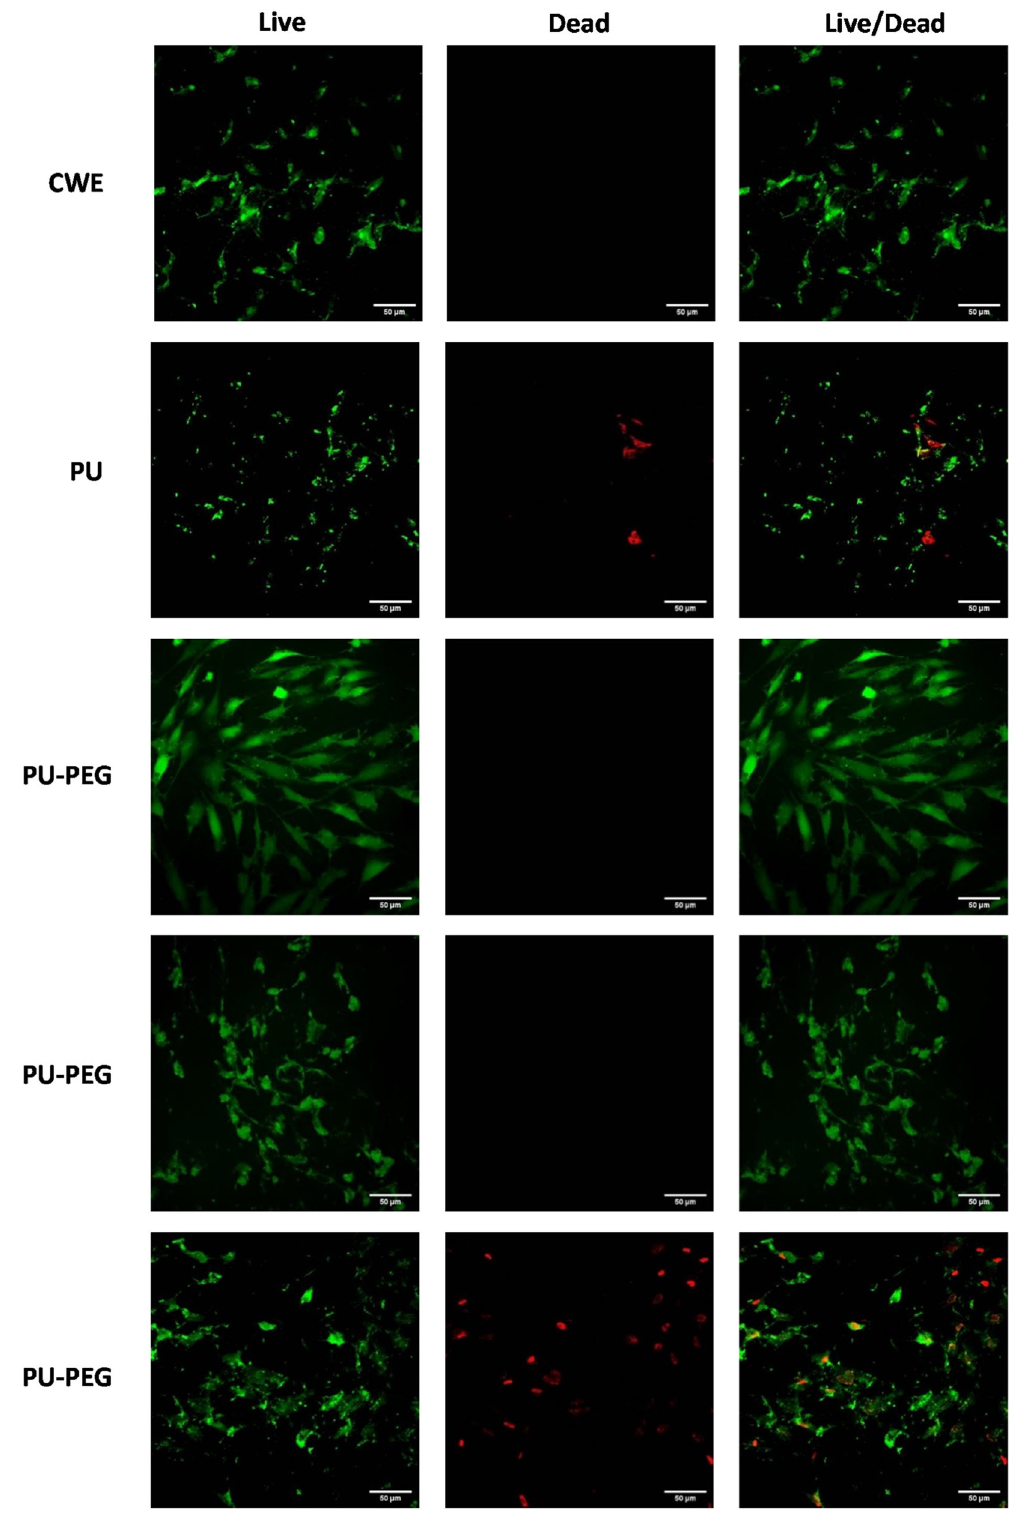
Fig. 10 Confocal laser images of LIVE/DEAD staining of osteoblasts in contact with extracts of the fi lms for 24